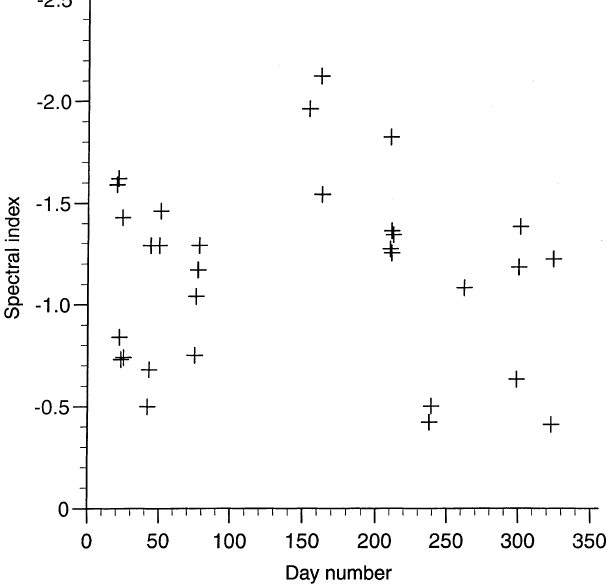
Fig. 9. The daily-mean spectral index (slope) for each of the days of data evaluated over the height range 76–86 km